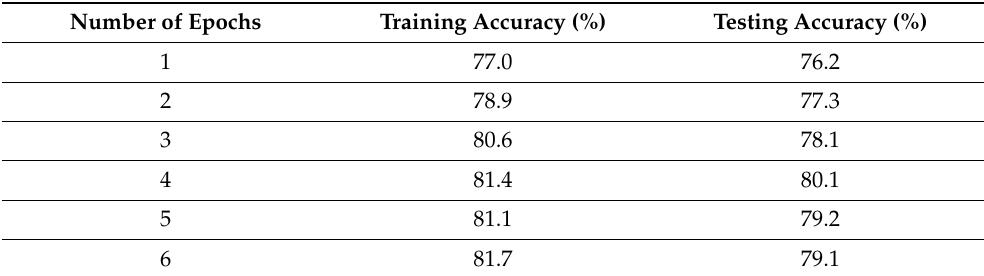
Table 2. Accuracy results of 10 learning epochs for the elementary learning